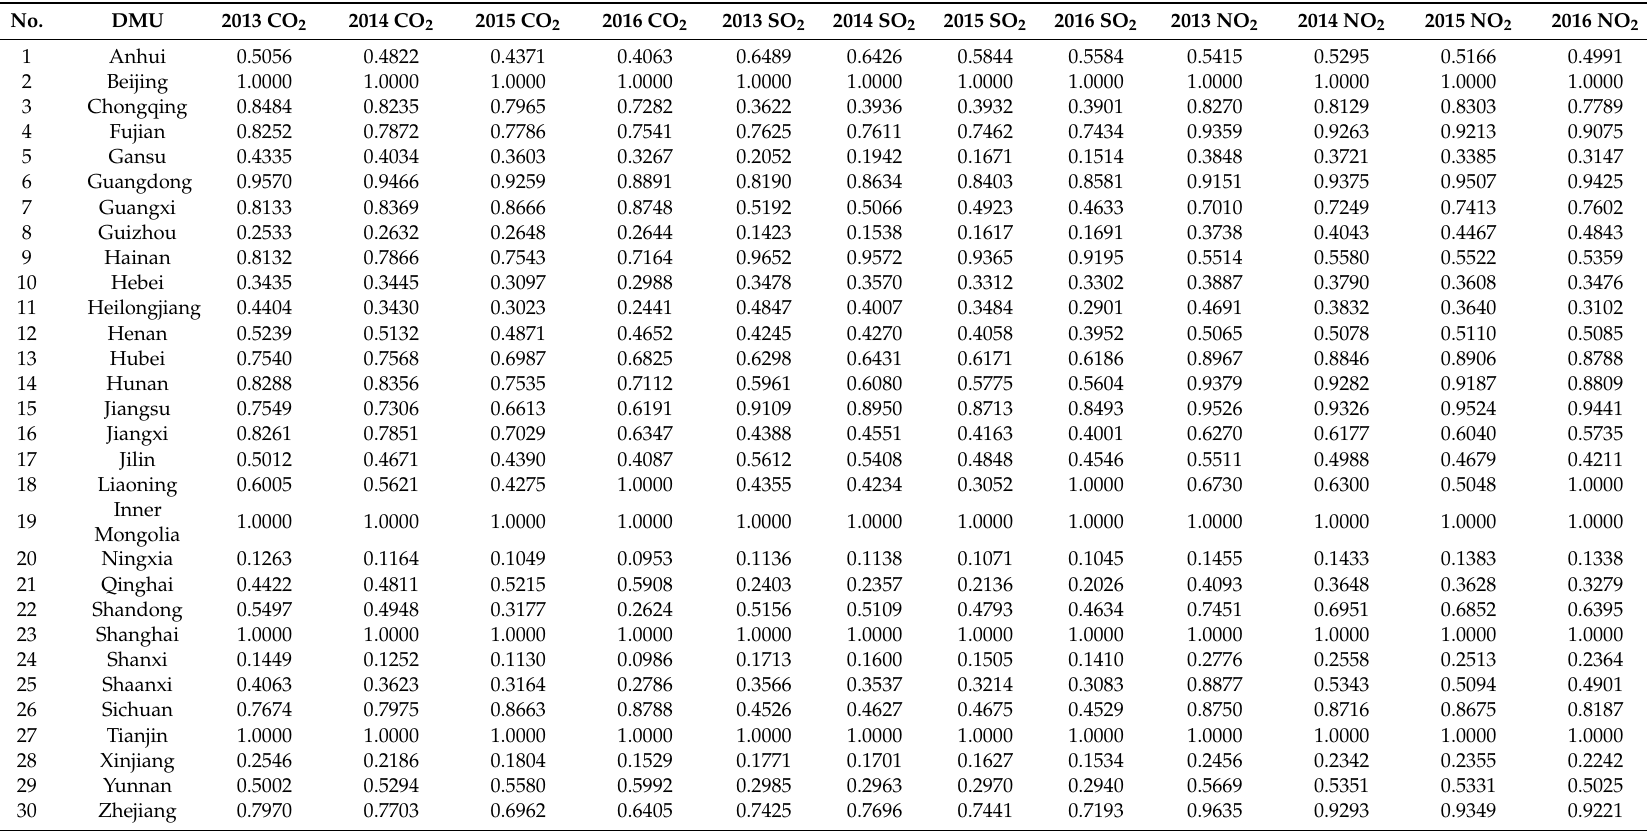
Table 10. 2013–2016 CO 2 , SO 2 , and NO 2 e ffi